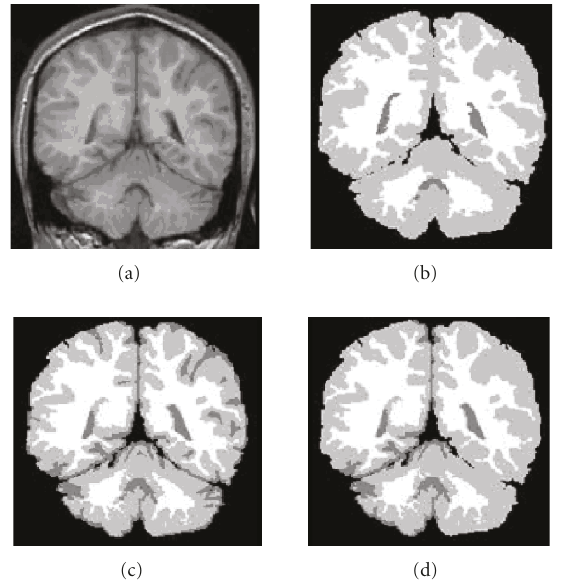
Figure 5: Segmentation result [WM (bright), GM (intermediate brightness), and CSF (dark)] of direct MC algorithm on a typical slice of IBSR dataset (slice 20 of subject 11 3): (a) T1 image, (b) reference image, (c) and (d) segmentation result using automatic seed selection and optimum seeds,